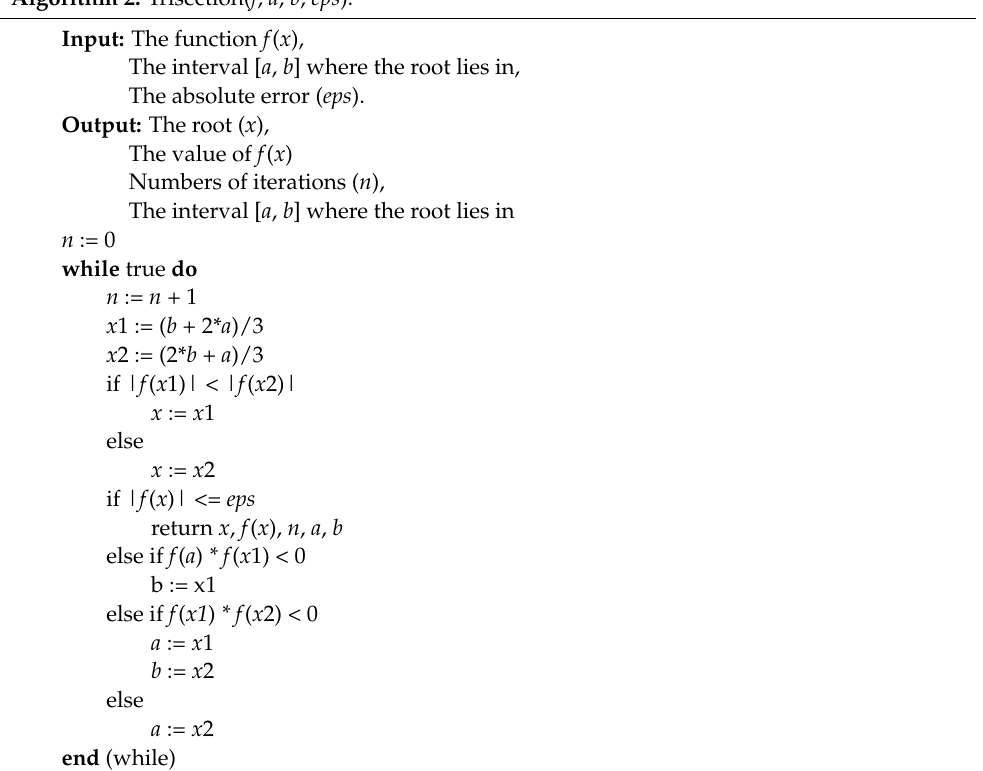
Algorithm 2. Trisection( f , a , b , eps